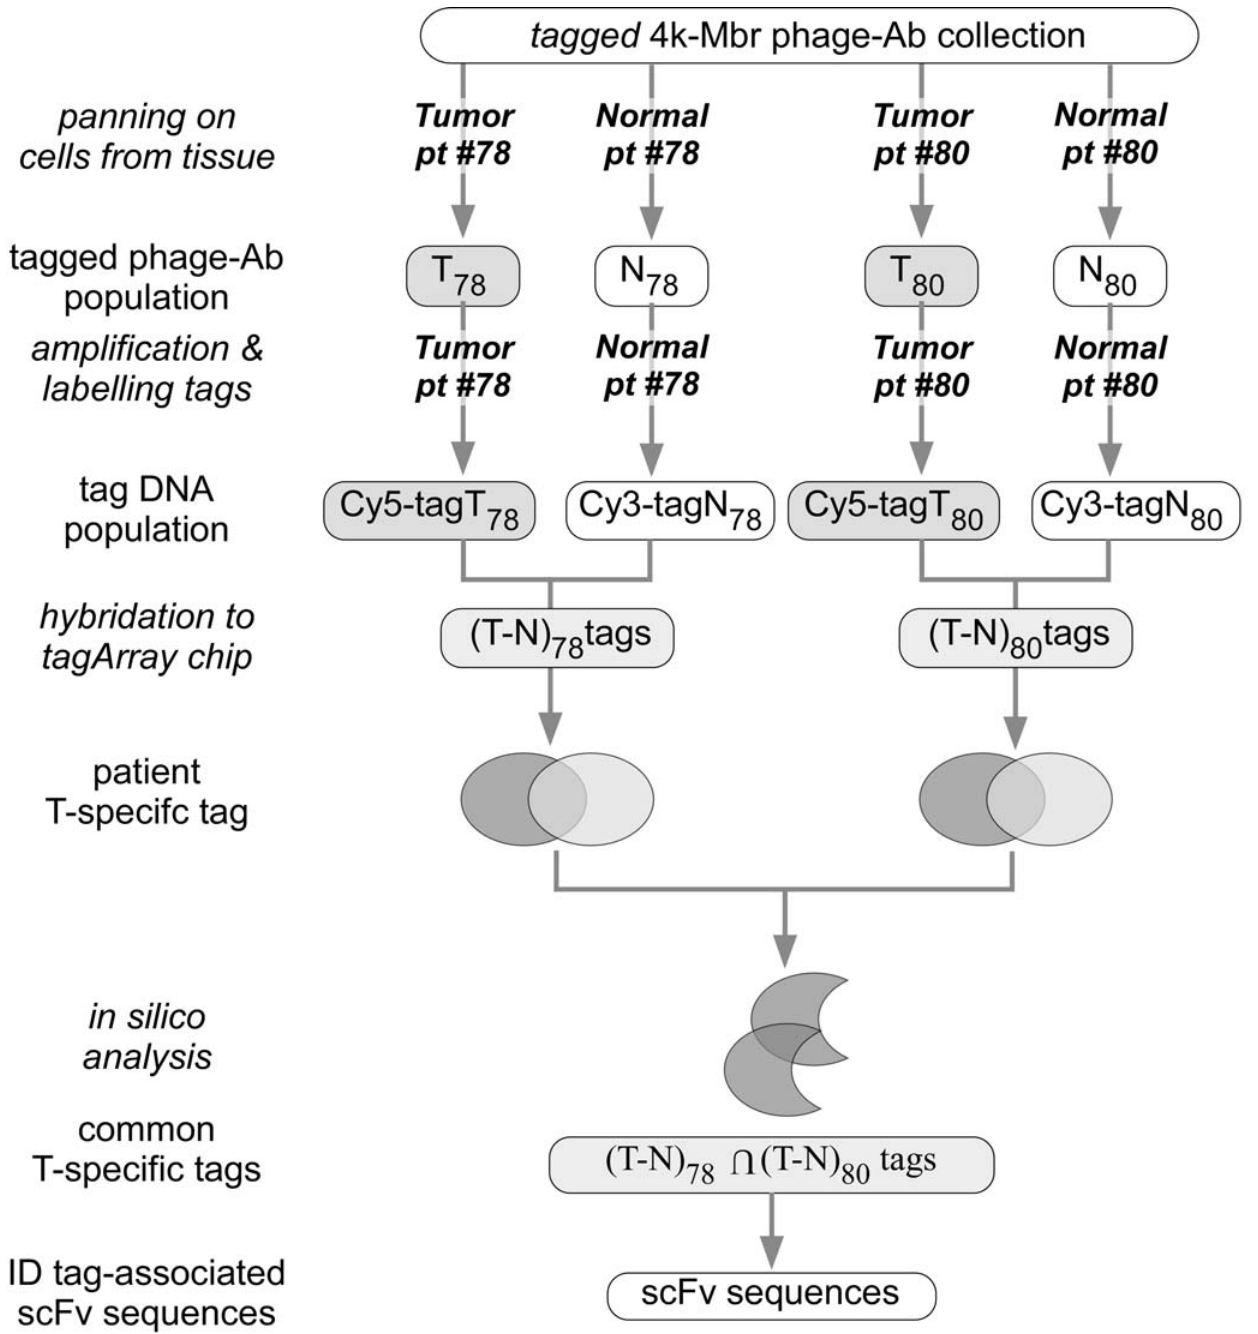
Figure 2. Workflow of the tagArrayscreening procedure employed to identify tumor-specific phage-Abs.